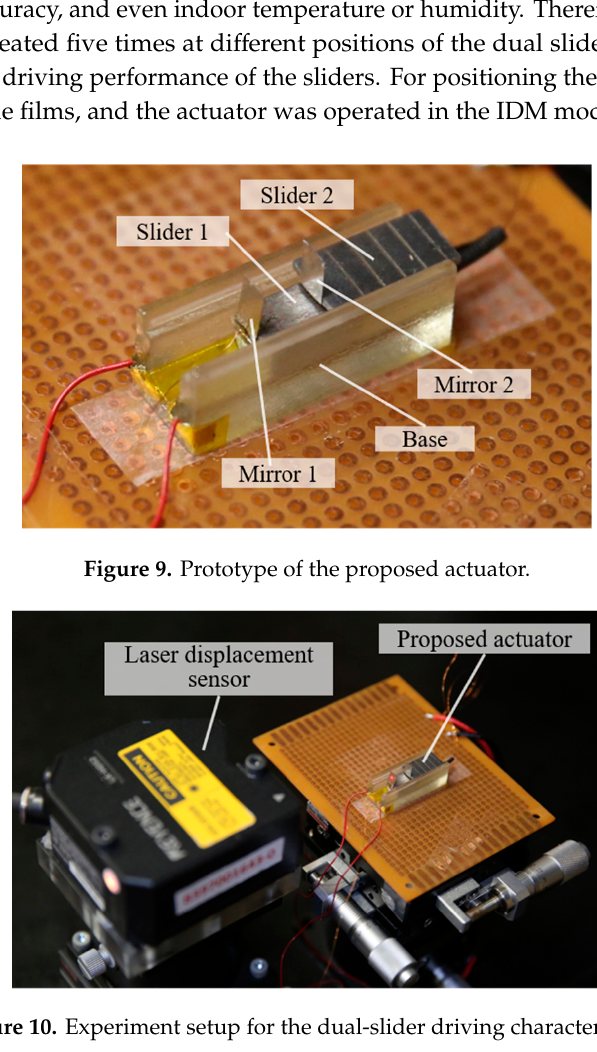
Figure 11. Driving characteristics of the slider 1 at different voltages.